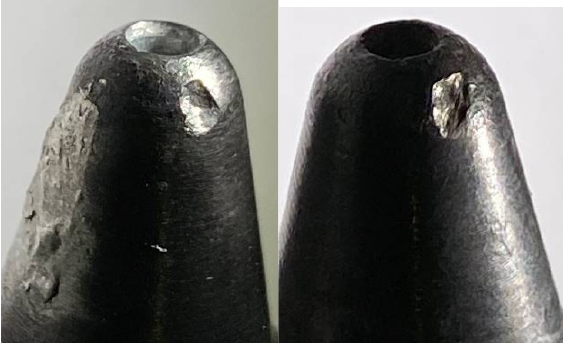
Figure 20. Failure mode of the ZIN injection contact zone by spalling.